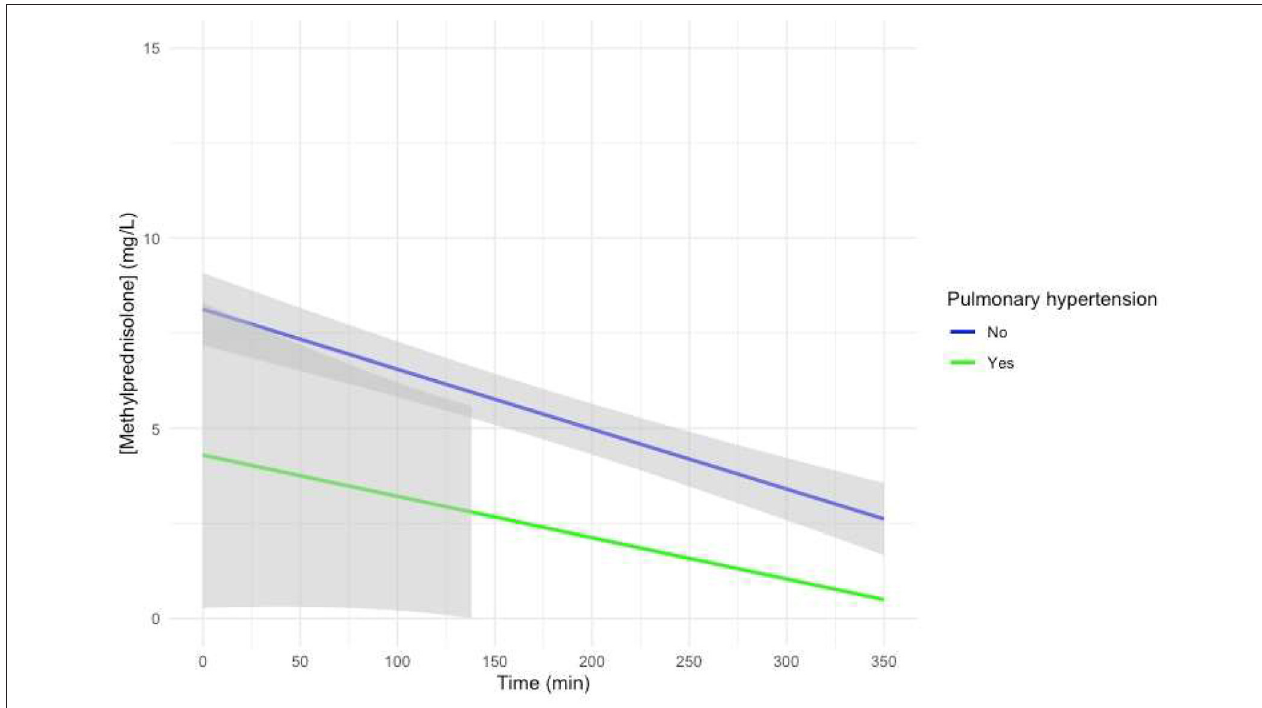
FIGURE 4 | Predicted MP concentration (mg/L) vs. time (min) for patients treated for pulmonary hypertension with sildenafil after initiation of CPB based on the linear mixed-effects model. Gray ribbons: 95% confidence interval. T = 0: start of